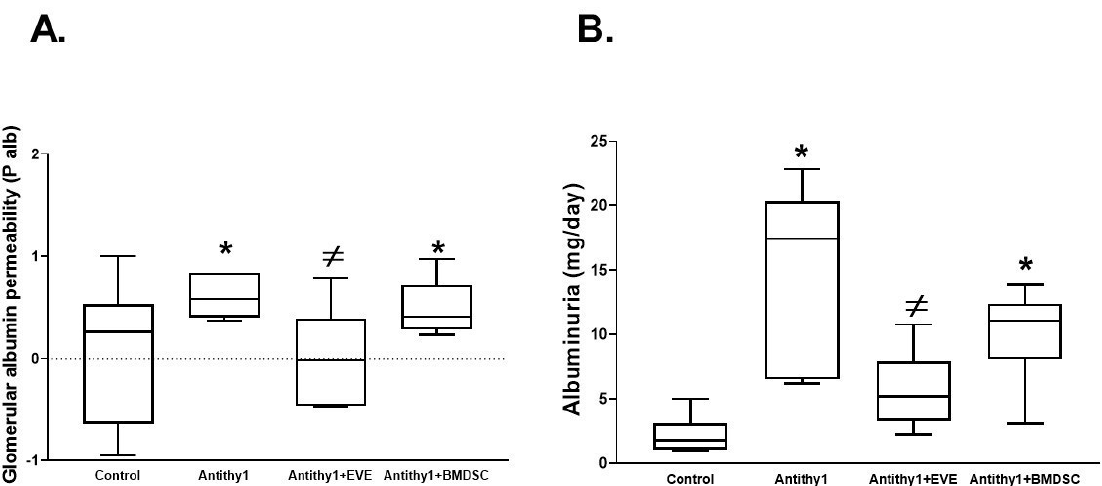
Figure 2. Glomerular permeability to albumin ( A ) and albuminuria ( B ) in control and anti-Thy1-injected rats +/- everoli- mus (2 mg/kg daily) or single-dose administration of BMDSCs (10 6 cells/200 µL of PBS, i.v.) after a week of injection of anti-Thy1. Only everolimus treatment significantly reduced the elevation in glomerular permeability to albumin and al- buminuria in anti-Thy1-injected rats (n = 6–8, * vs. control and ≠ vs. anti-Thy1-injected rats).